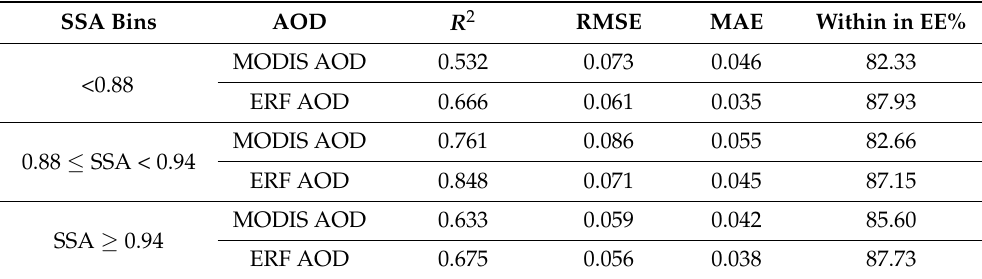
Table 6. The accuracy of the observed (AERONET) AOD, MAIAC AOD and estimated AOD by the ERF model for statistically different SSA